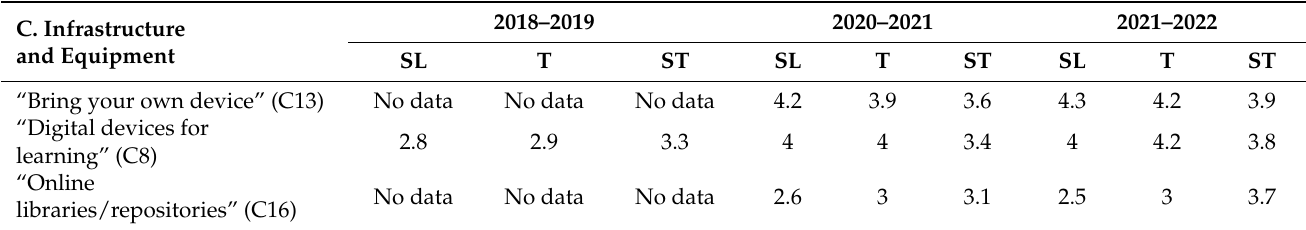
Table 4. Descriptive statistics on Infrastructure and